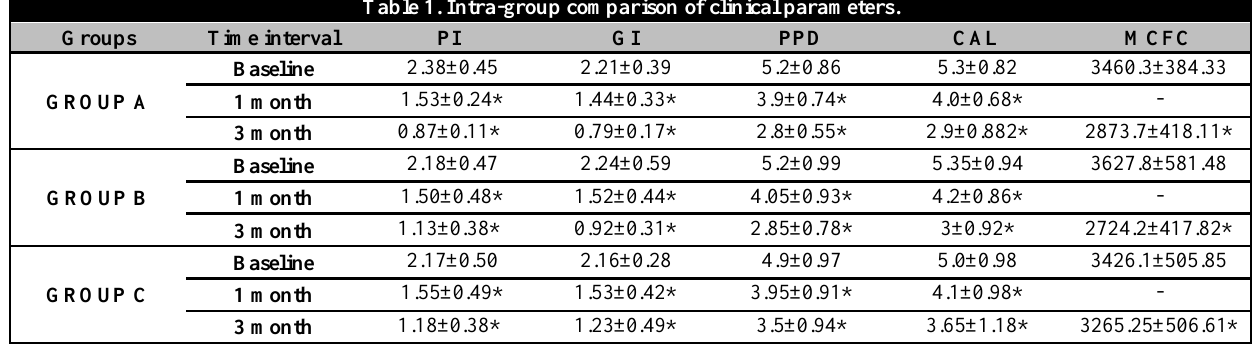
Table 1. Intra-group comparison of clinical